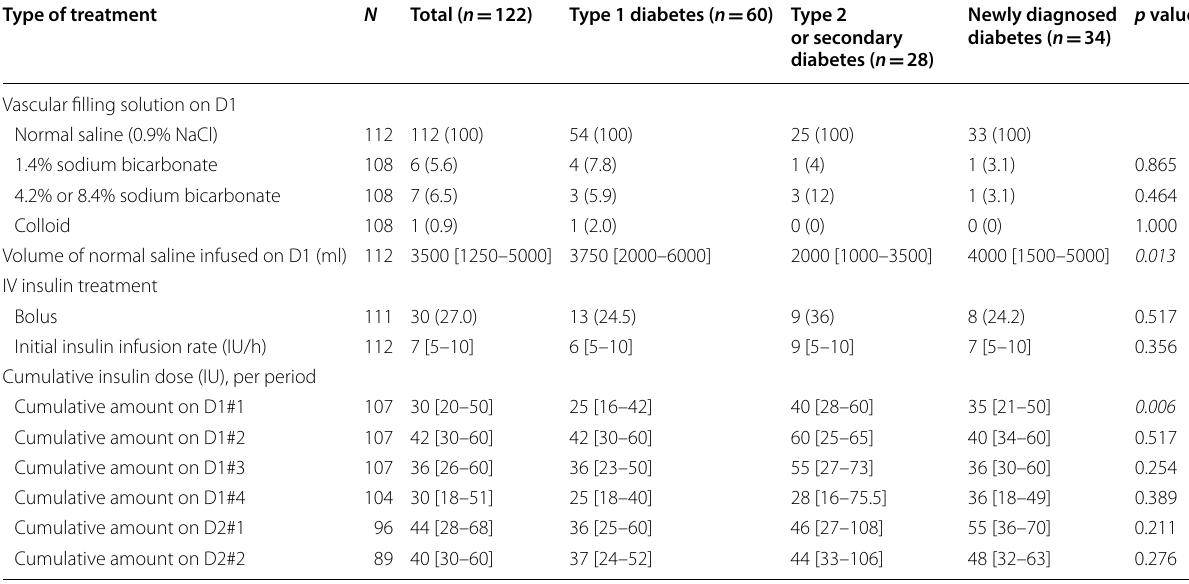
Table 2 Treatment according to the type of